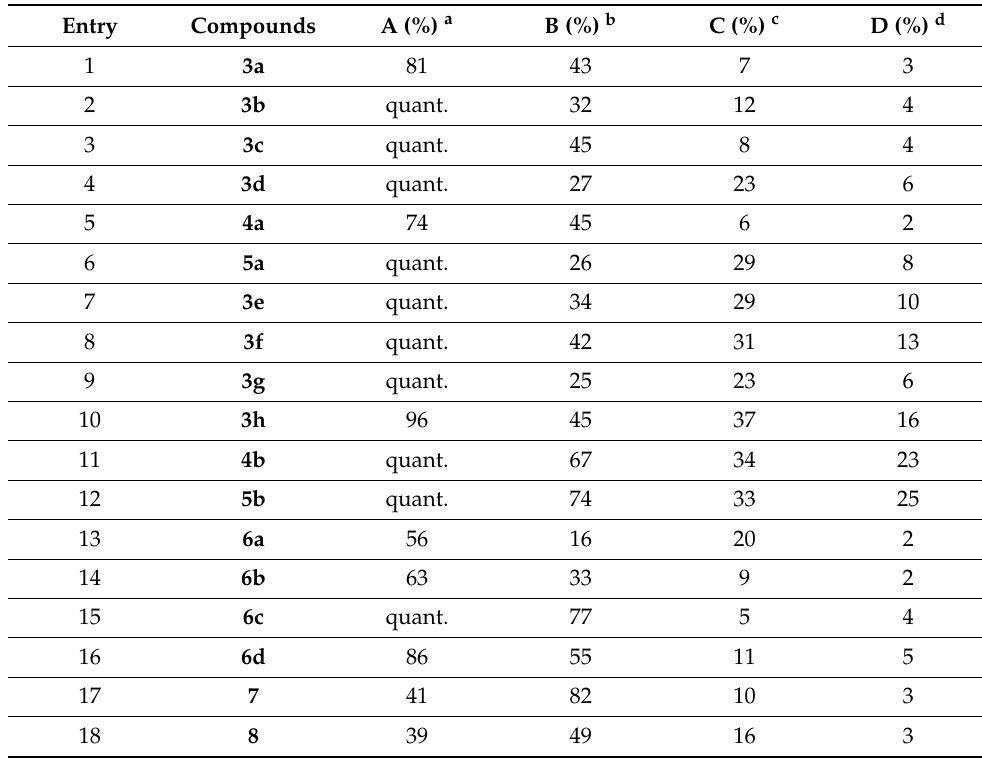
Table 3. The chemical yields of each step for the corresponding peptides.